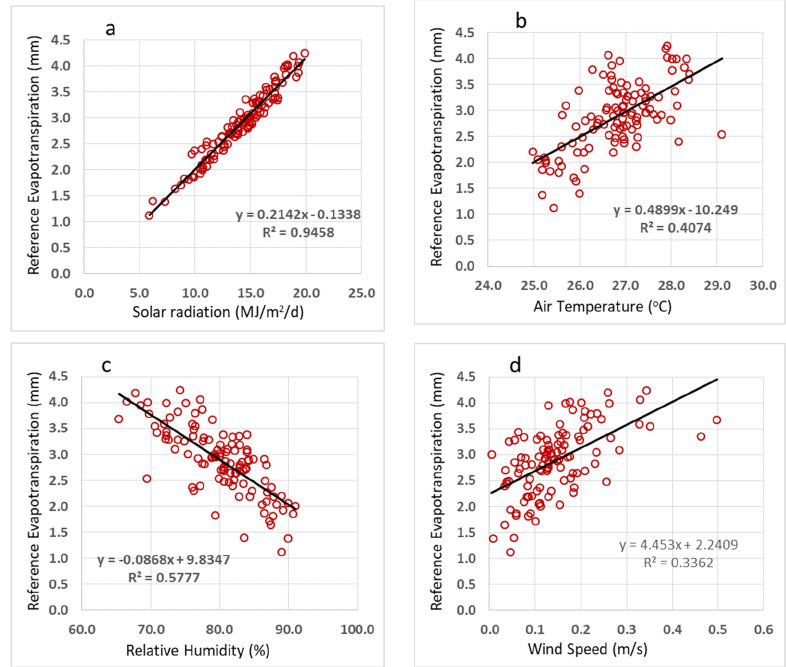
Figure 4. The linear correlation among reference evapotranspiration and weather parameters: ( a ) reference evapotranspiration vs. solar radiation; ( b ) reference evapotranspiration vs. air temperature; ( c ) reference evapotranspiration vs. relative humidity; ( d ) reference evapotranspiration vs. wind speed.